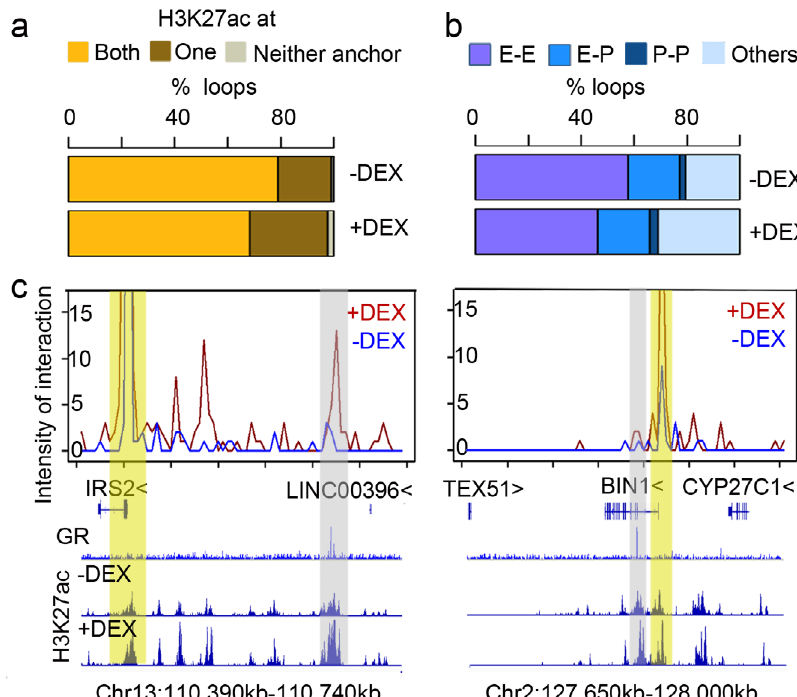
Fig. 3 Transcription-centered interaction loops captured by H3K27ac Hi-ChIP. a The stack plot shows the proportion of H3K27ac within both, one, or neither anchors. b The proportion of E – E (enhancer – enhancer), E – P (enhancer – promoter), P – P (promoter – promoter) interactions in HiChIP pro fi le. c Virtual 4C pro fi le at IRS2 or BIN1 locus with GR, H3K27ac signal with or without DEX treatment. The yellow bar highlights the promoter of IRS2 or BIN1. Gray bar highlights the GR